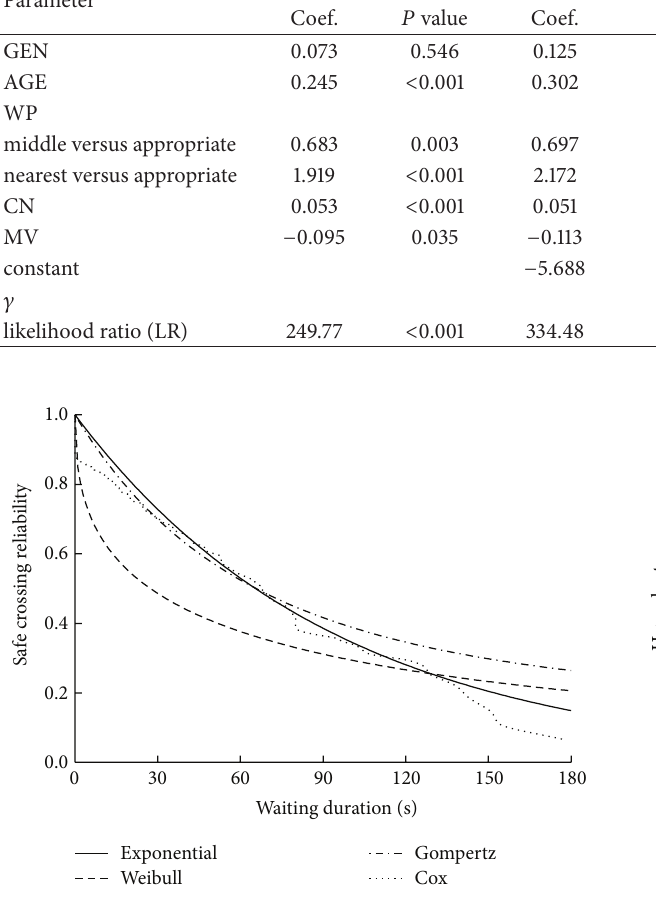
Figure 2: Crossing reliability versus waiting duration with different hazard models. Figure 3: Hazard rate versus waiting duration with different hazard